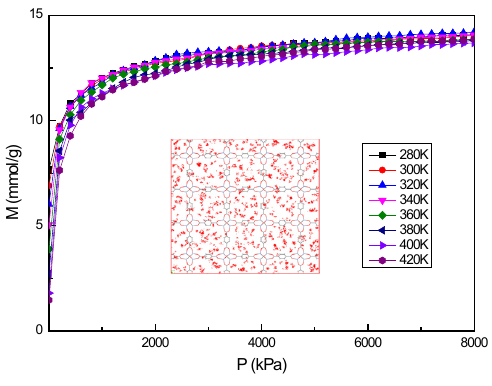
Figure 4: The adsorption isotherms of R125 adsorb in UIO-66 structure.